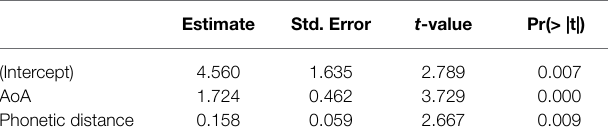
TABLE 3 | Results of a linear regression model of the relation between F-letter score and SD of the selected language measures. Estimate Std. Error t -value Pr(>